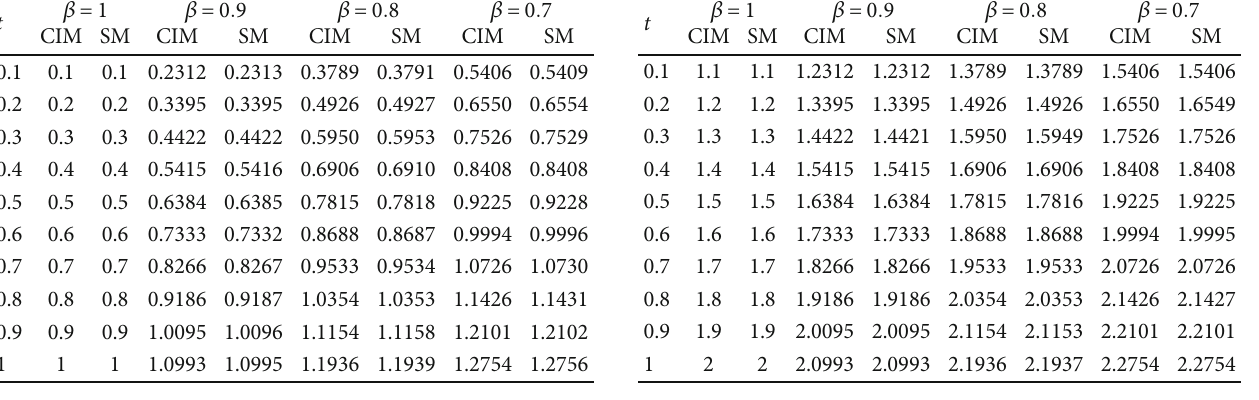
Table 7: Absolute errors for β = 1 using the two numerical schemes for di ff erent values of N and M corresponding to Problem